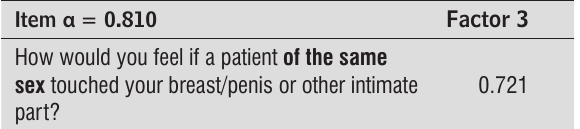
Table 3 - Factor analysis from the extraction of the discom- fort domain items